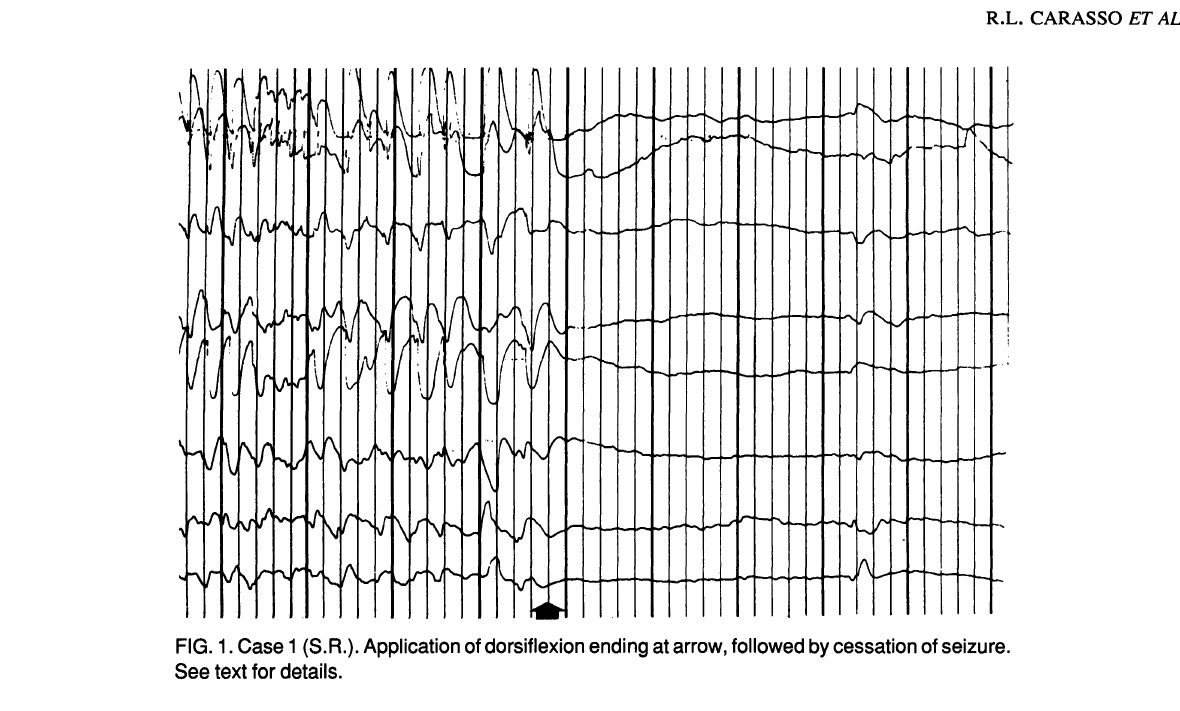
FIG. 1. Case 1 (S.R.). Application of dorsiflexion ending at arrow, followed by cessation of seizure. See text for